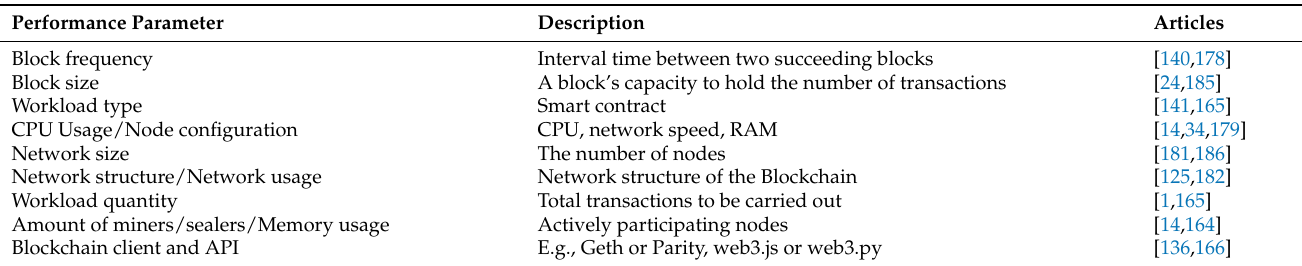
Table 14. Identified performance